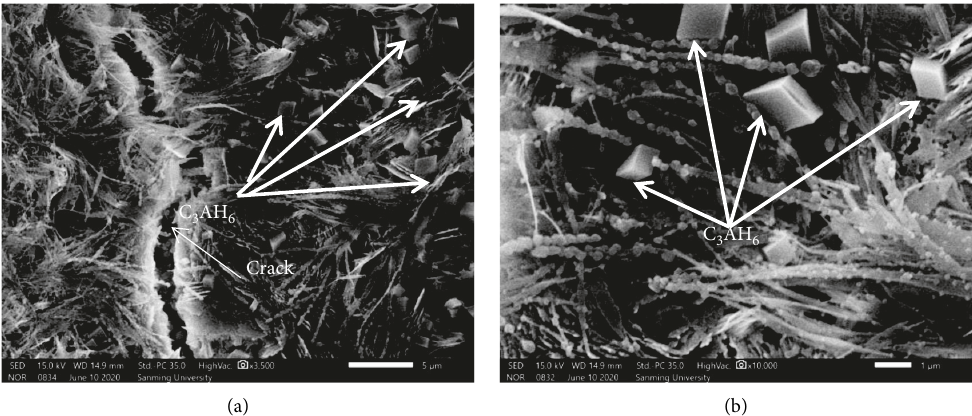
Figure 8: SSP-cement hydration microscopic morphology with the age of 7d: (a) magnify 3500 times and (b) magnify 10000